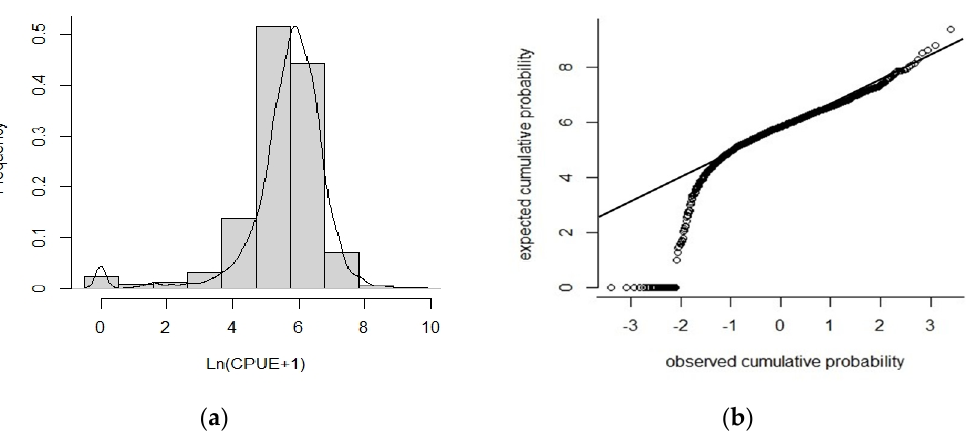
Figure 3. Statistical distribution tests for ln(CPUE h +1): ( a ) frequency distribution of ln(CPUE h +1); ( b ) nominal Q − Q plot of ln(CPUE h +1).